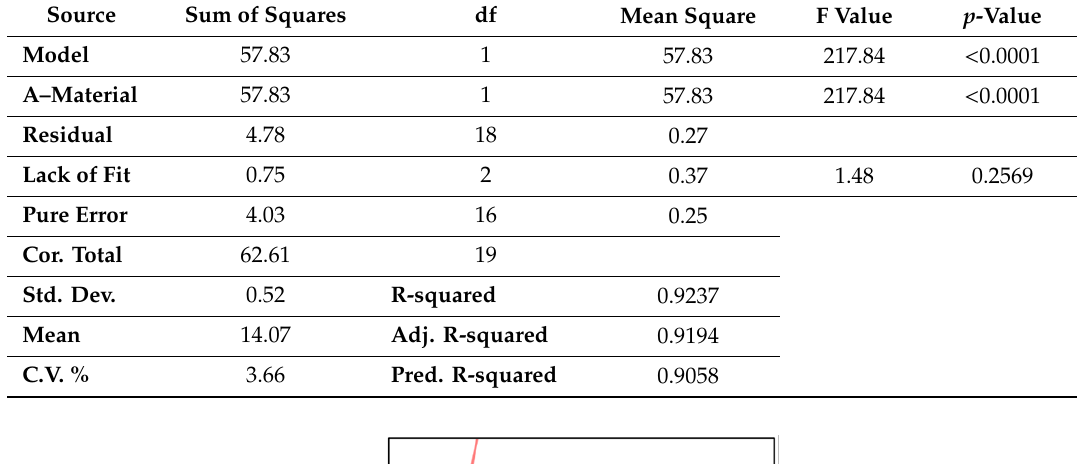
Figure 11. Average ILSS versus displacement curves. Table 6. ANOVA table for ILSS test (response: short-beam strength). Table 6. ANOVA table for ILSS test (response: short-beam strength).